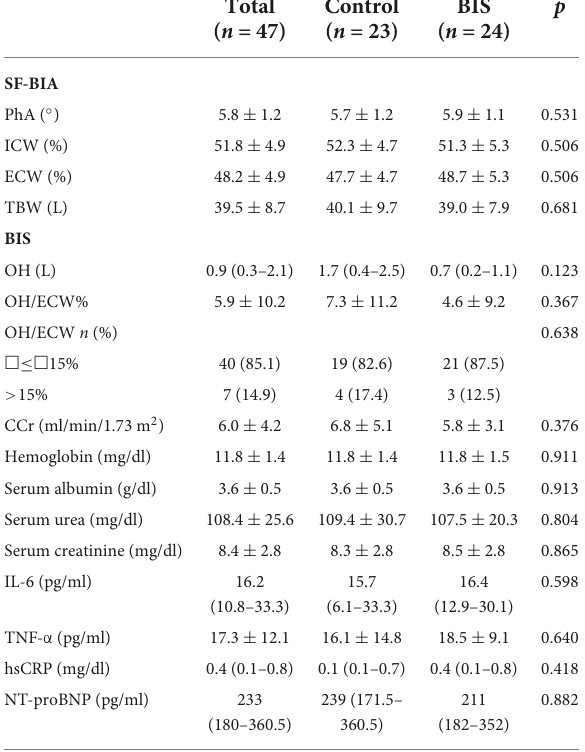
TABLE 2 Hydration status and laboratory parameters of the control and BIS groups at the beginning of the